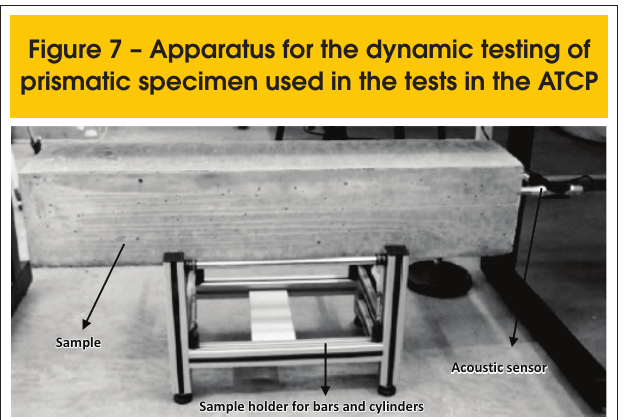
Figure 7 – Apparatus for the dynamic testing of prismatic specimen used in the tests in the ATCP